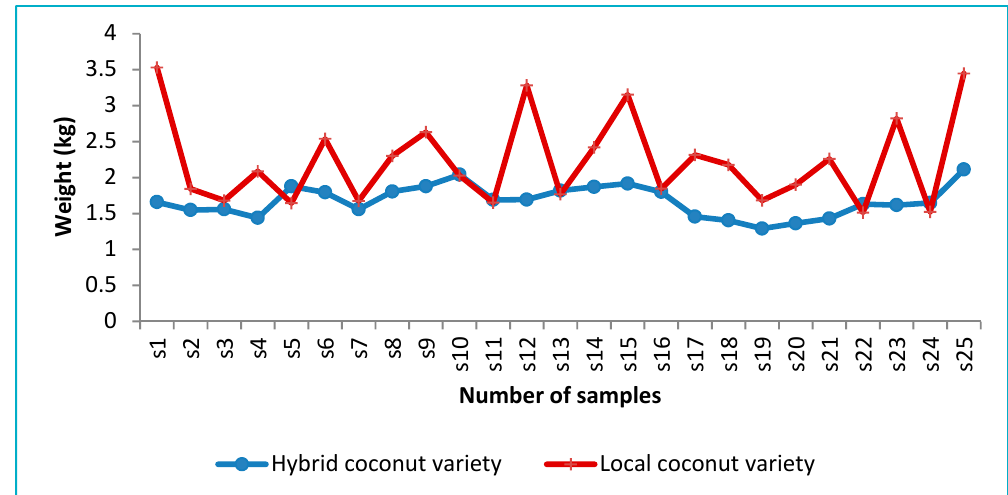
Figure 6. Plot of whole coconut waste samples and their weights.